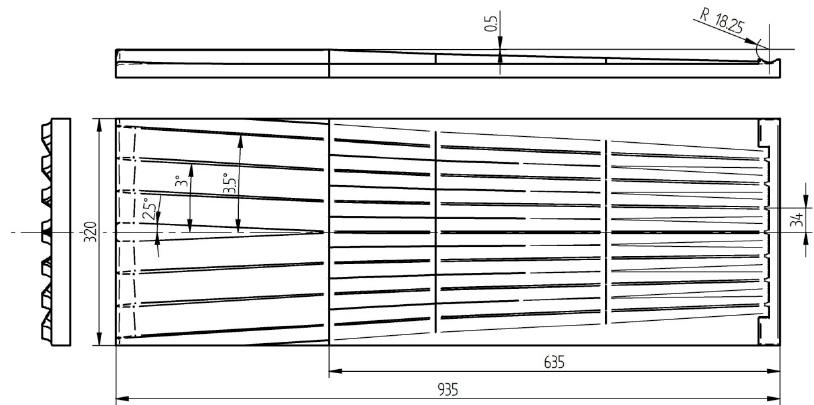
Figure 4. Flat tool for cross rolling of Ø40 mm diameter balls, with the chosen dimensions in mm given.